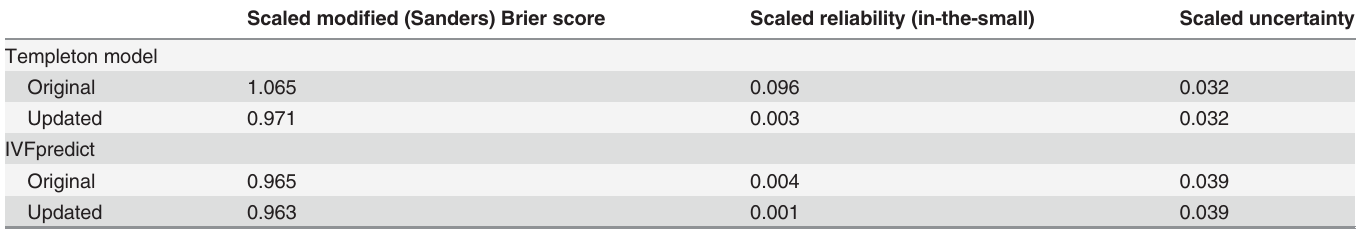
Table 4. Brier scores and decomposition for IVFpredict and Templeton models, from 130,960 IVF